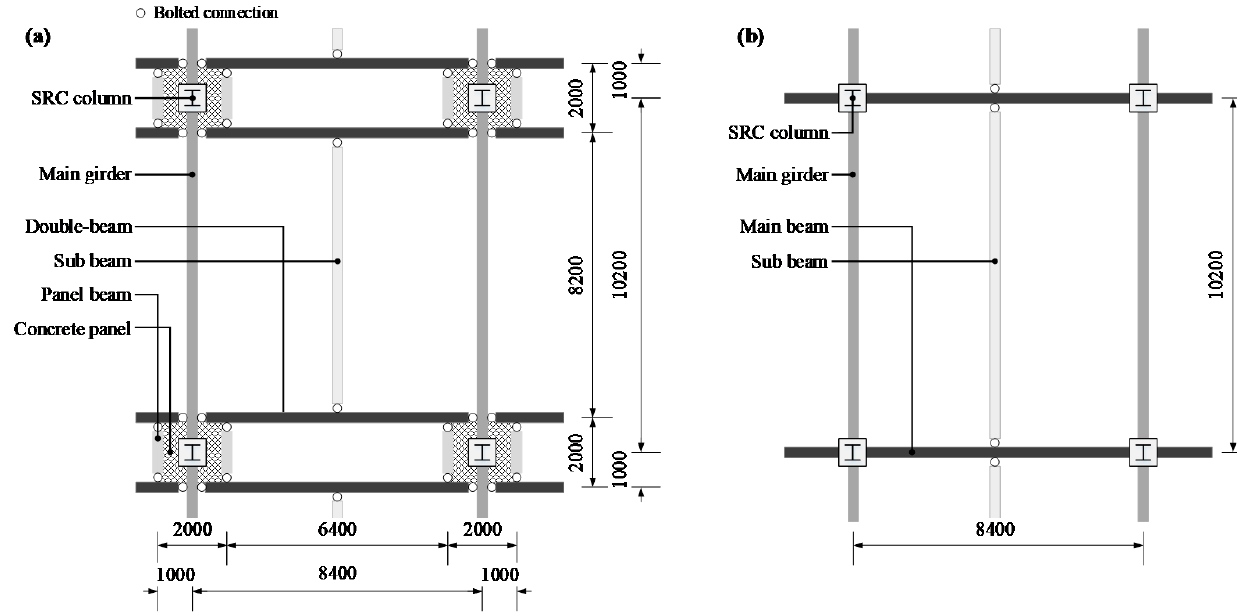
Figure 2. Structural plan for an underground space of buildings used for parking lots according to the applied structural systems: ( a ) Steel double-beam floor system with concrete panel (DBO system) and ( b ) general beam-girder system (GBG system).